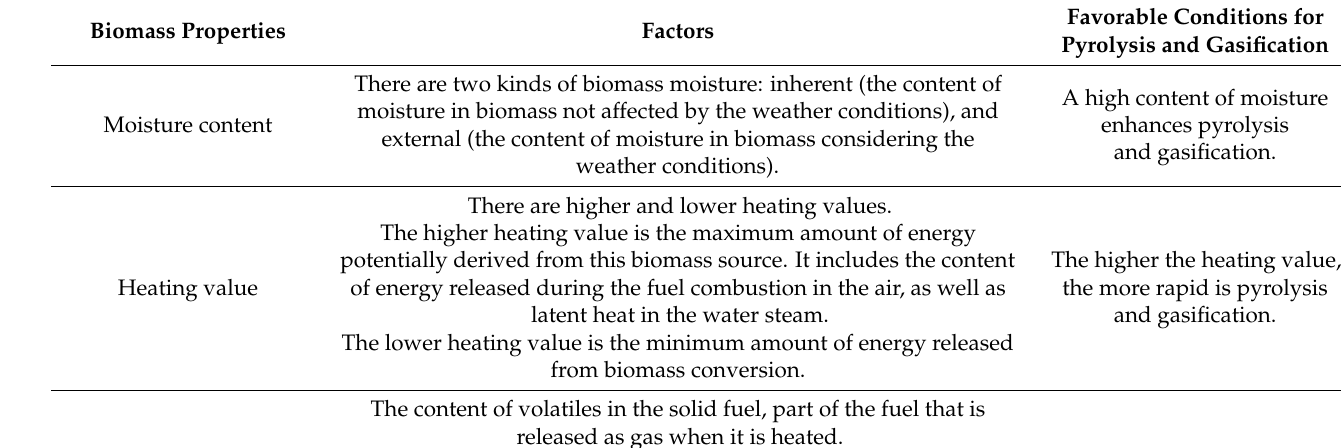
Table 5. Factors in choosing biomass type for pyrolysis and